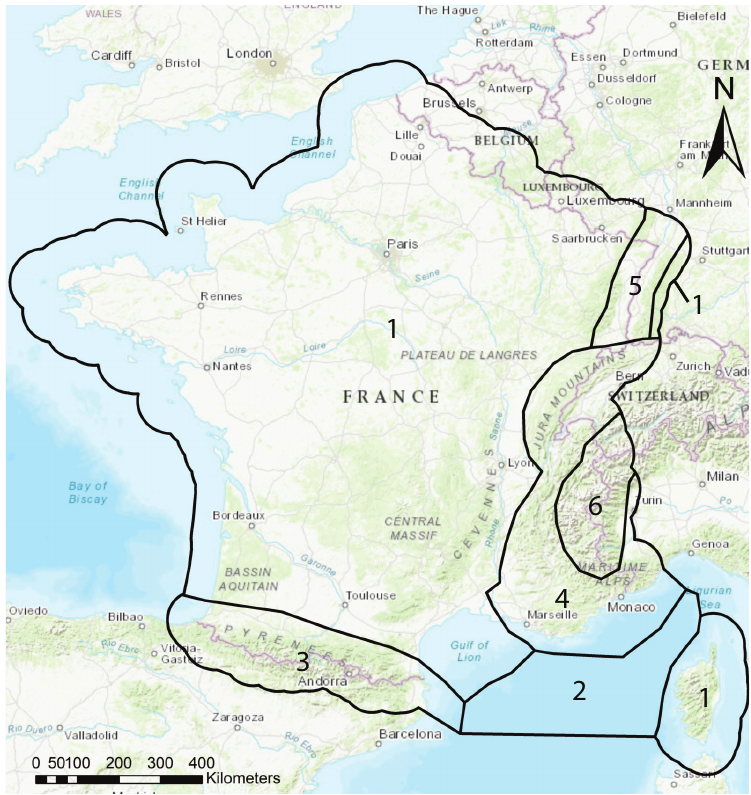
Figure 4. SHARE tectonic regionalization [32] used in this paper. Regions 1 correspond to Stable Continental Regions (SCR). Region 2 represents the Oceanic Crust (OC). Regions 3 (Pyrenees) and 4 (Alps) represent compressional active shallow regions, whereas regions 5 (Rhine Basin) and 6 (Alps) correspond to extensional ones.